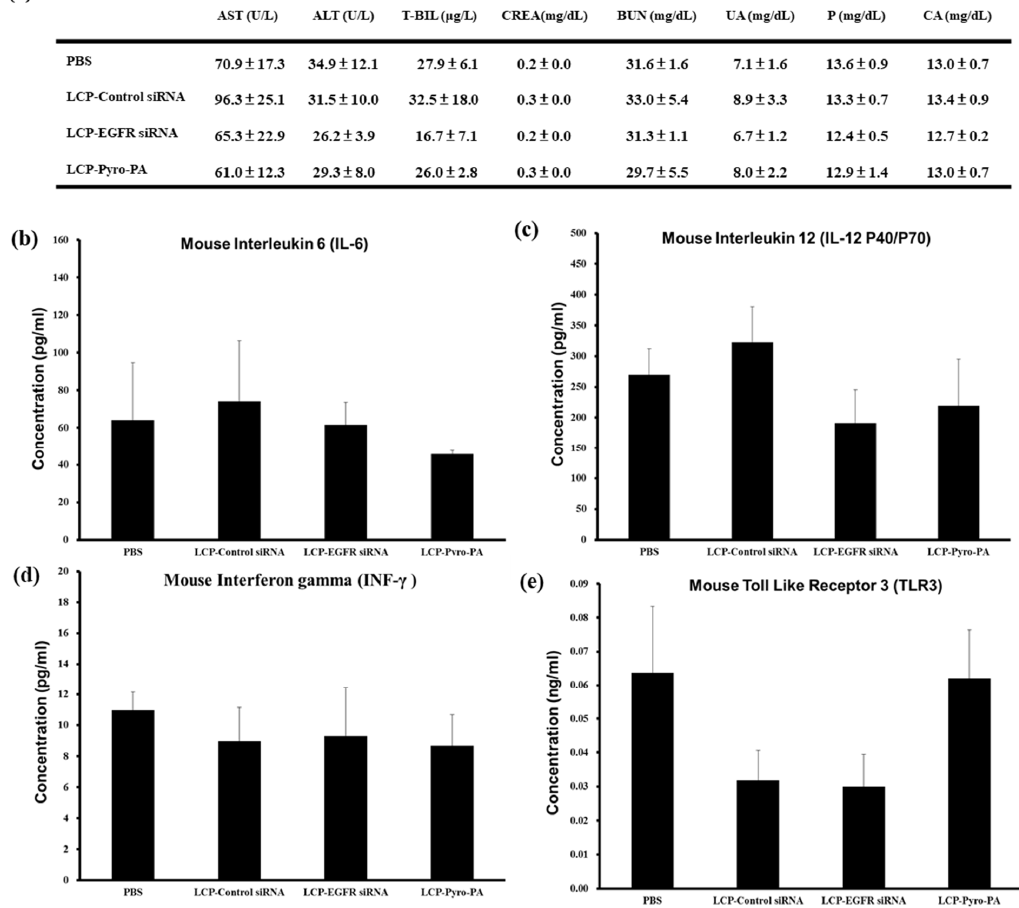
Figure 8. In vivo toxicity and inflammatory response. ( a ) The serum levels of C57BL/6 mice for liver Figure 6. Mouse Interleukin 6 (IL-6) ( b ), interleukin-12 p40/70 ( c ), interferon gamma ( d ), Toll-like receptor 3 ( e ). Data presented as mean ± SD ( n = 3), * p > 0.05 compared to PBS (control) group.